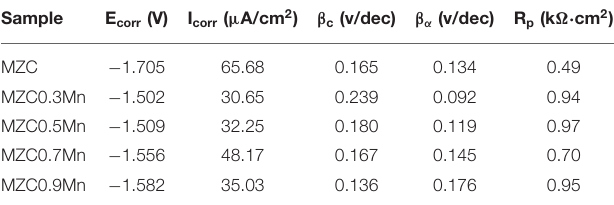
TABLE 2 | Electrochemical properties of as-extruded MZC, MZC0.3Mn, MZC0.5Mn, MZC0.7Mn, and MZC0.9Mn alloys. Sample